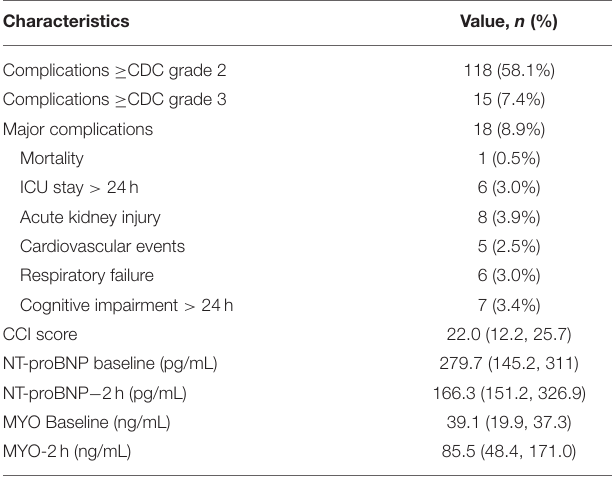
TABLE 2 | Characteristics of 30-day complications after surgery and perioperative level of NT-proBNP, MYO ( n = 196).